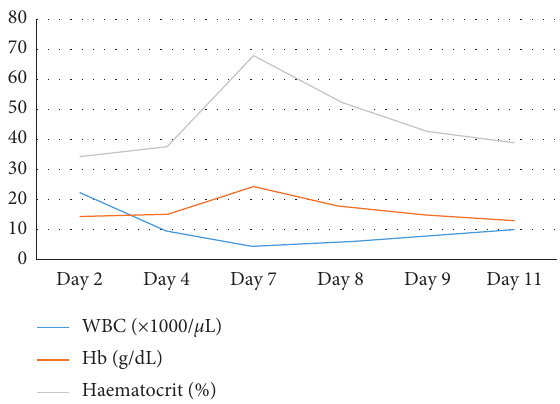
Figure 1: Image showing the trends of white blood cell, haemo- globin, and haematocrit with postoperative day.